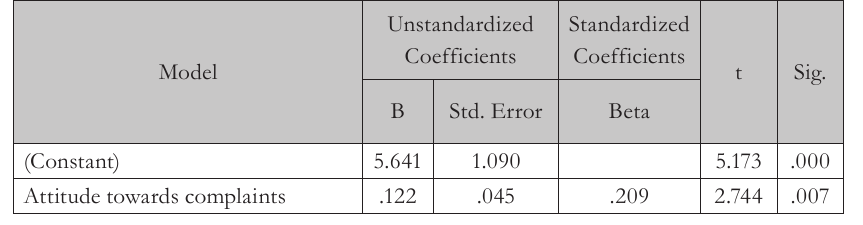
Tab. 5 - Influence of antecedent variables on Voice, Source: Researchers’ Calculation,